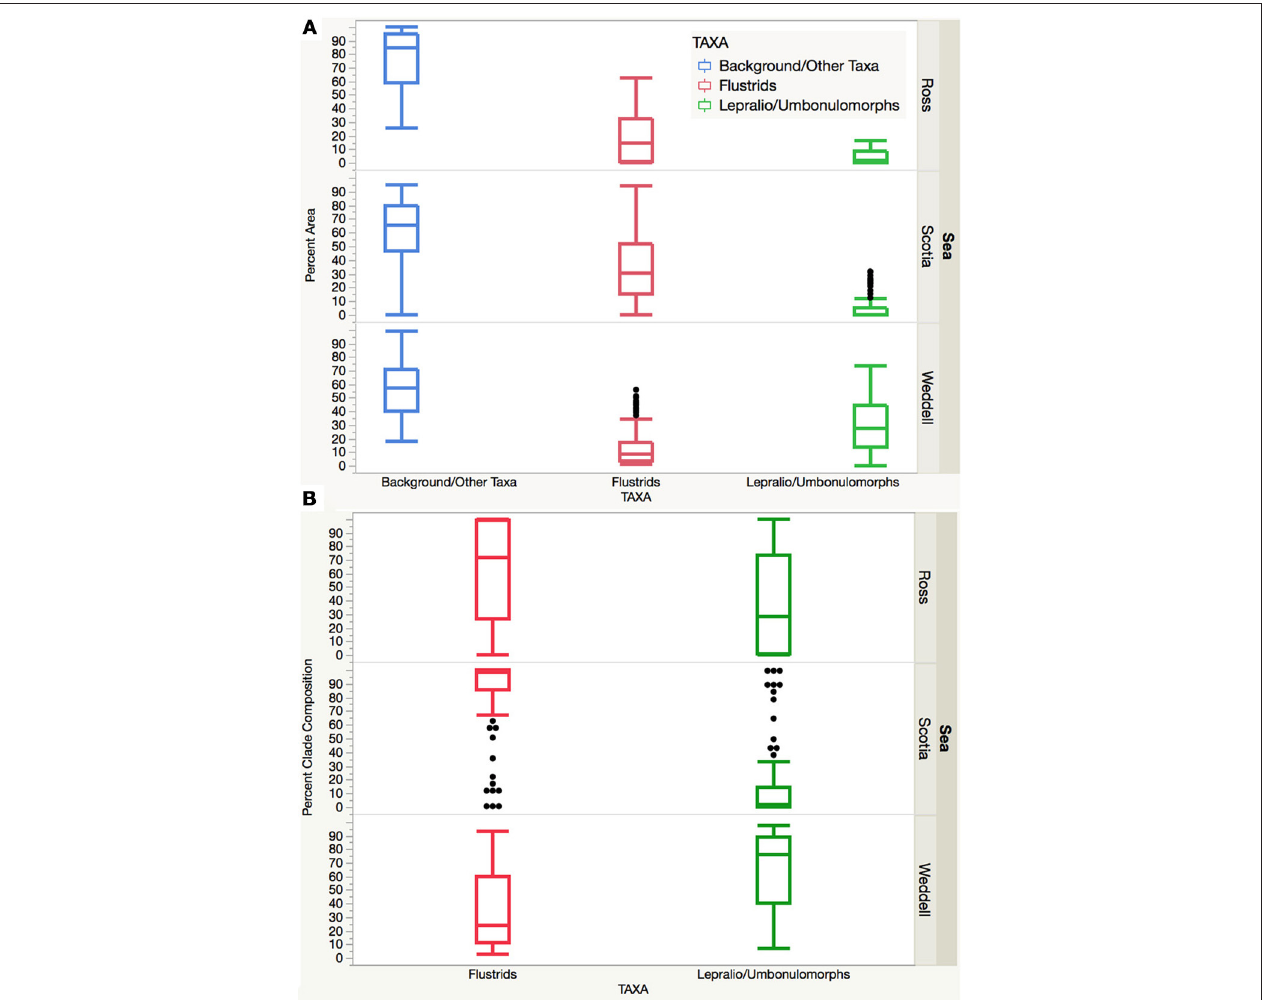
FIGURE 4 | (A) Box plot showing the percent area of the background substrate/other taxa, flustrids, and lepralio-umbonulomorphs among the three Antarctic regions. (B) Box plot showing the percent clade composition of flustrid and lepralio-umbonulomorph bryozoans among the three Antarctic